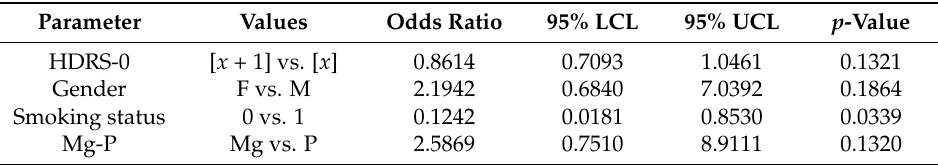
Table 3. Odds ratio values for the parameters evaluated in this model—the odds of achieving 50% improvement in HDRS scores (efficacy).